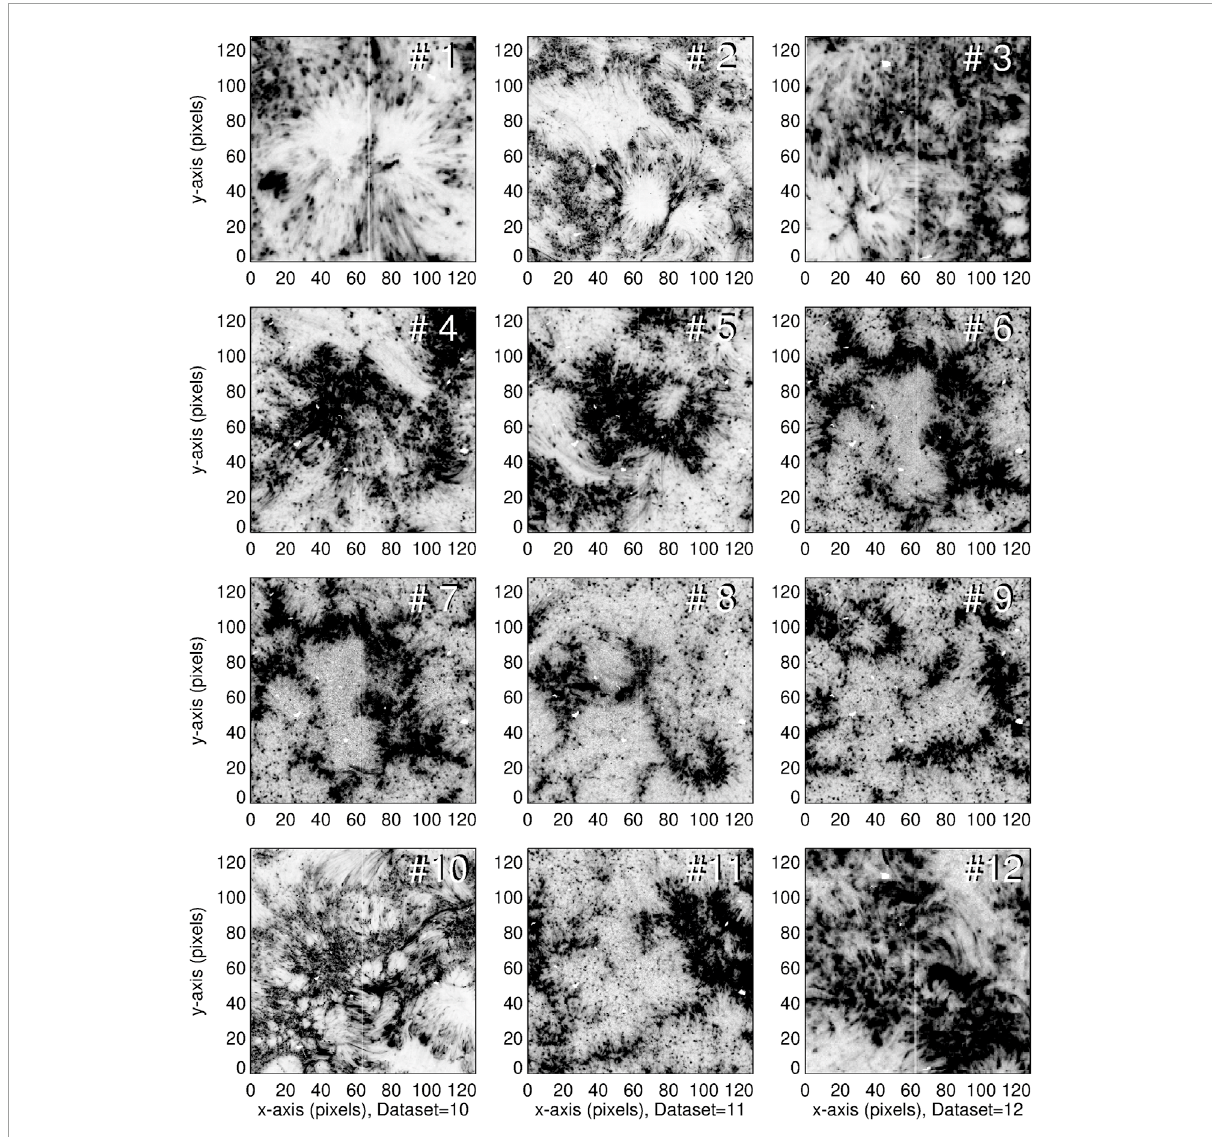
FIGURE 3 Intensity maps of 12 different active regions, observed with IRIS SJI 1400 Å. Black color indicates emission, and white color indicates the faint